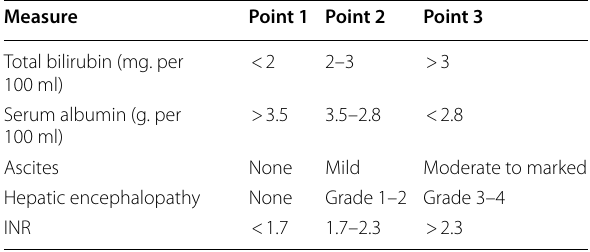
Table 1 CTP classification of chronic liver